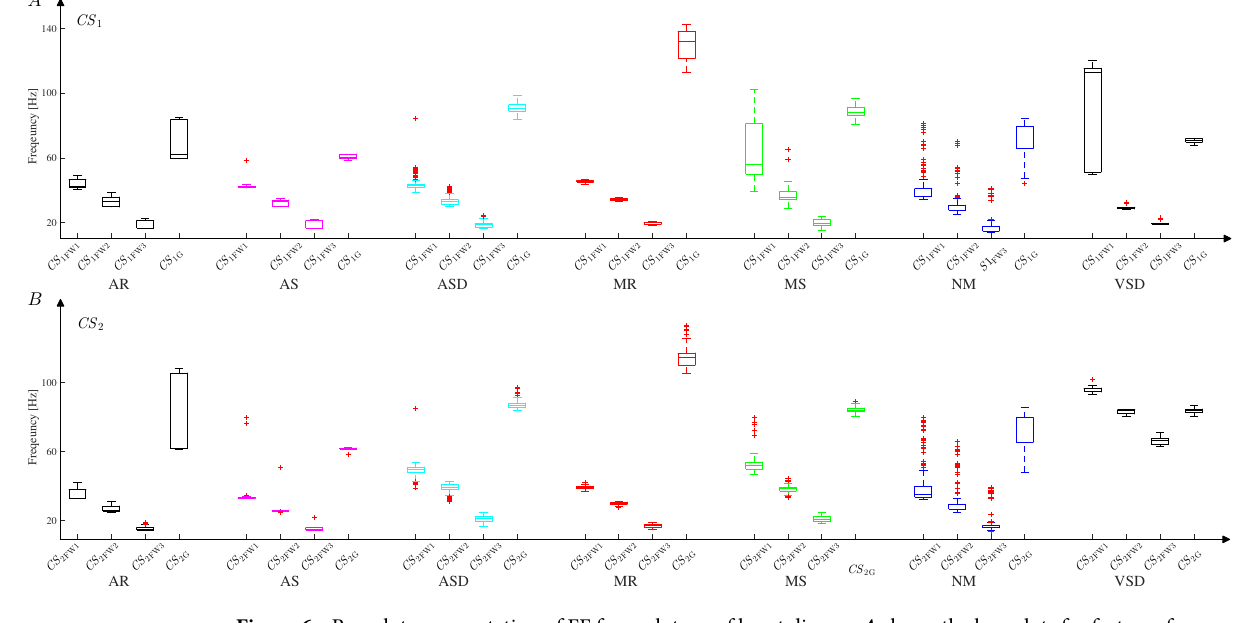
Figure 6. Box plot representation of FF for each type of heart disease. A shows the box plots for features from CS 1 . In addition, B represents the features from CS 2 are distinguished from other sounds; 3 (cid:31) The NM sound is easy to distinguish from other sounds using CS 1FW3 (Fig. 6A). 4 (cid:31) The AR and VSD sounds are easy to distinguish from the other sounds using CS 2FW3 , as shown in Fig. 6B; 5 (cid:31) Fig. 6A indicates that CS 1G can be used to easily distinguish MR from other sounds and the AS and ASD sounds from other sounds; 6 (cid:31) Fig. 6B shows that the distribution of CS 2G from AS sounds is different from that for other sounds, except NM sounds. The analysis results discussed above indicate that different combina- tions of several features defined by Eq. (15) can be used to distinguish among various types of heart disease. Therefore, to simplify features and develop a diagnostic method that is simple and effective, dimension reduction is used to determine new features; this process is described in detail as follows.